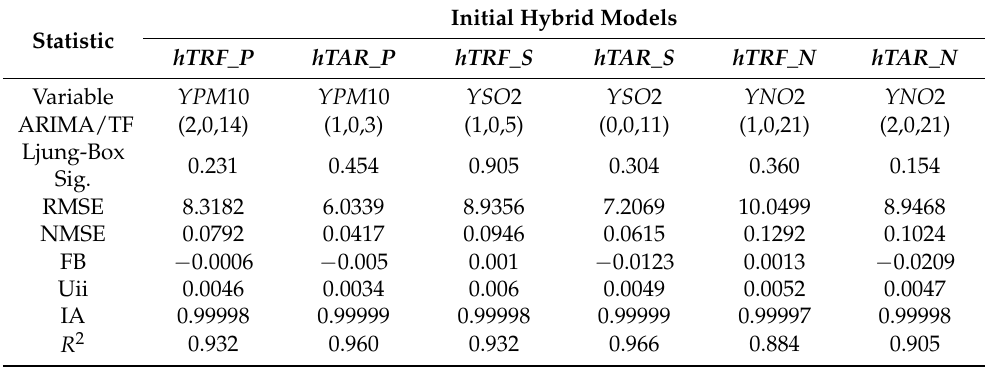
Table 5. Performance statistics of the hybrid RF-ARIMA/TF and ARC_ARIMA/TF initial models.